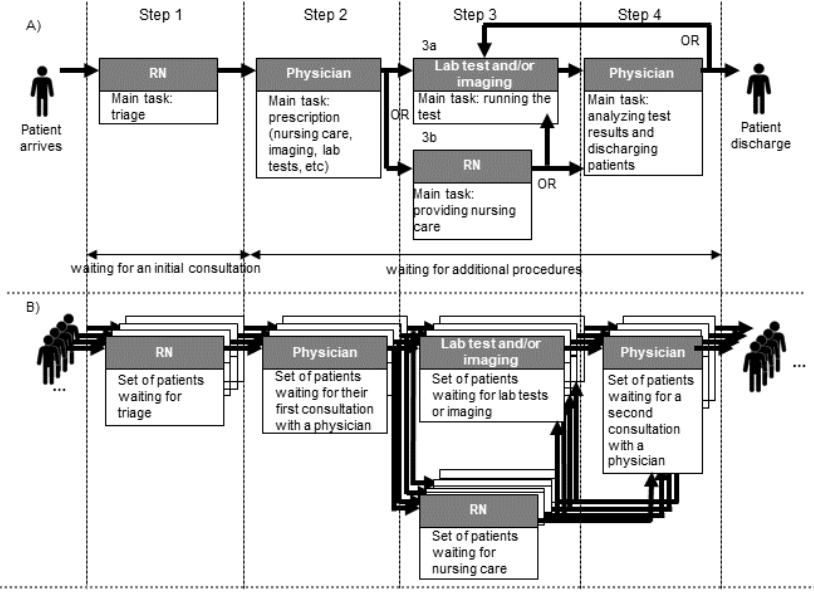
Figure 3. Schematic description of patients’progression through the pediatric emergency department. Panel A describes the main tasks to be performed by the registered nurses and the physician at each step in the care process for a single patient. Panel B highlights that the pediatric emergency department care process is the same for all patients. RN: registered